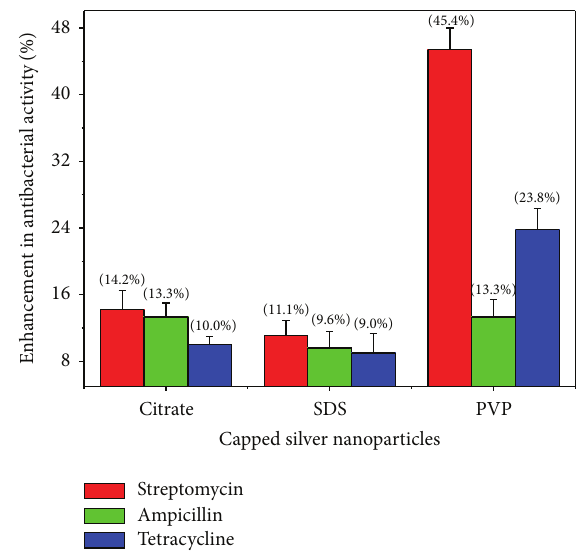
Figure 7: The percentage of enhancement in antibacterial activity observed for the antibiotics in combination with silver nanoparti- cles, against the bacterial strain S. aureus ATCC